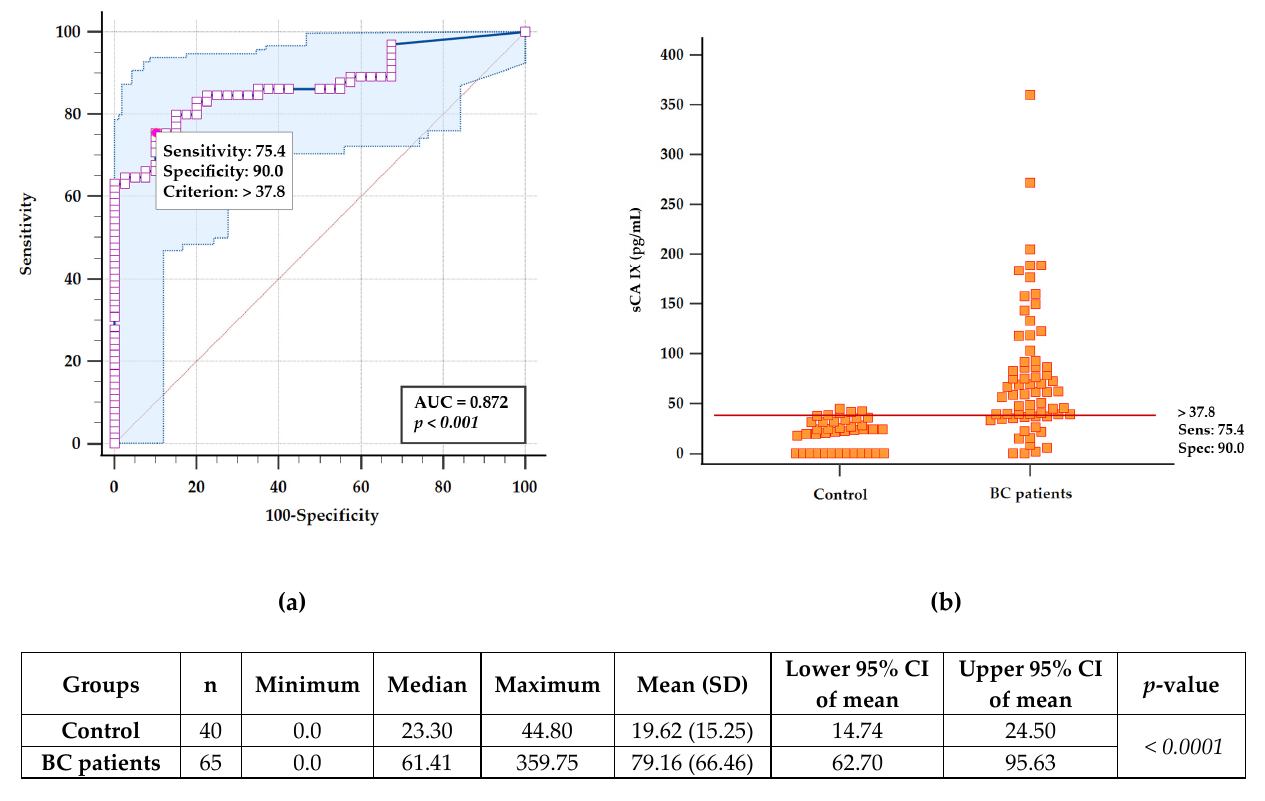
Figure A7. Receiver operating characteristic (ROC) curve analysis of Quantikine ® Human Carbonic Anhydrase IX Immunoassay (R&D ELISA): ( a ) ROC curve analysis was performed by MedCalc ® Statistical Software version 20.2 based on sCA IX values of BC patients (n = 65) included in the study versus apparently healthy volunteers (n = 40). The software calculated the area under the curve (AUC), the statistical significance of the difference between the groups of healthy (Control) and tested BC patients ( p < 0.001 ), and determined the best cut off according to Youden’s statistic; ( b ) interactive dot diagram of measured levels of sCA IX in both groups with the cut off line (red horizontal line); ( c ) the table shows summary statistical data of sCA IX (pg/mL) for each group: number of patients (n), minimum, median, maximum, mean with standard deviation (SD), lower 95% confidence interval (CI) for mean, upper 95% CI for median, and result of the Mann–Whitney test for independent samples ( p< 0.0001 ).